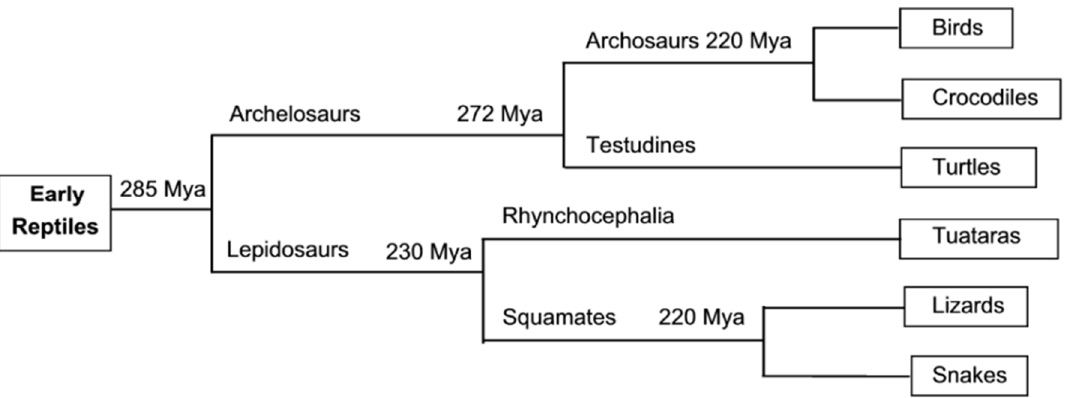
Figure 1. Phylogenetic classification of the sauropsids. The branching times are measured in millions of years (Mya) and are based on studies of mitochondrial DNA [1]. Figure reproduced from [5] with permission of Elsevier.